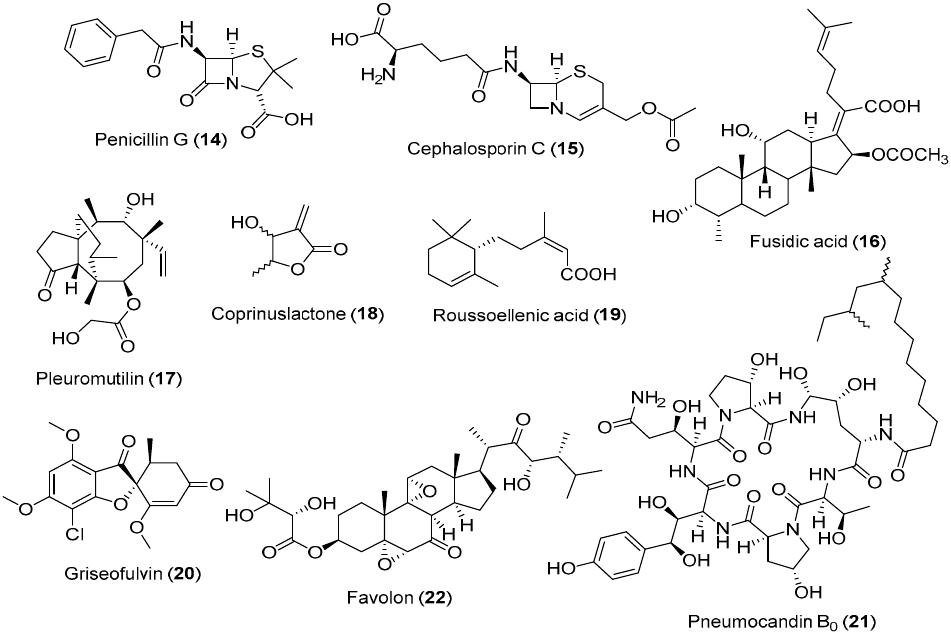
Figure 2. Selected fungal metabolites with antibiotic effect.